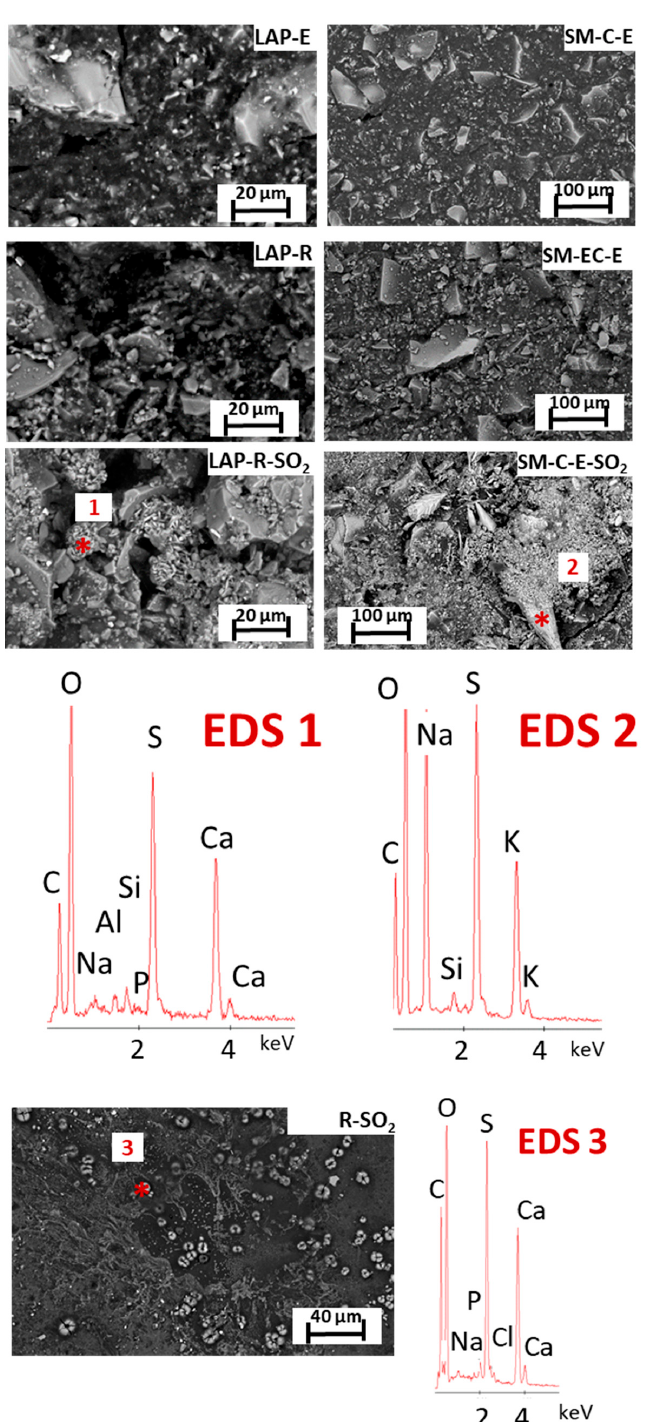
Figure 5. Scanning electron microscope (SEM) micrographs and energy-dispersive X-ray spectroscopy (EDS) spectra of LAP- and SM-paint mock-ups, before and after the SO 2 aging test. Also shown is the SO 2 aged rabbit glue (R) mock-up. Check Table 1 to better follow the paints labeling. –SO 2 shows the aged samples.